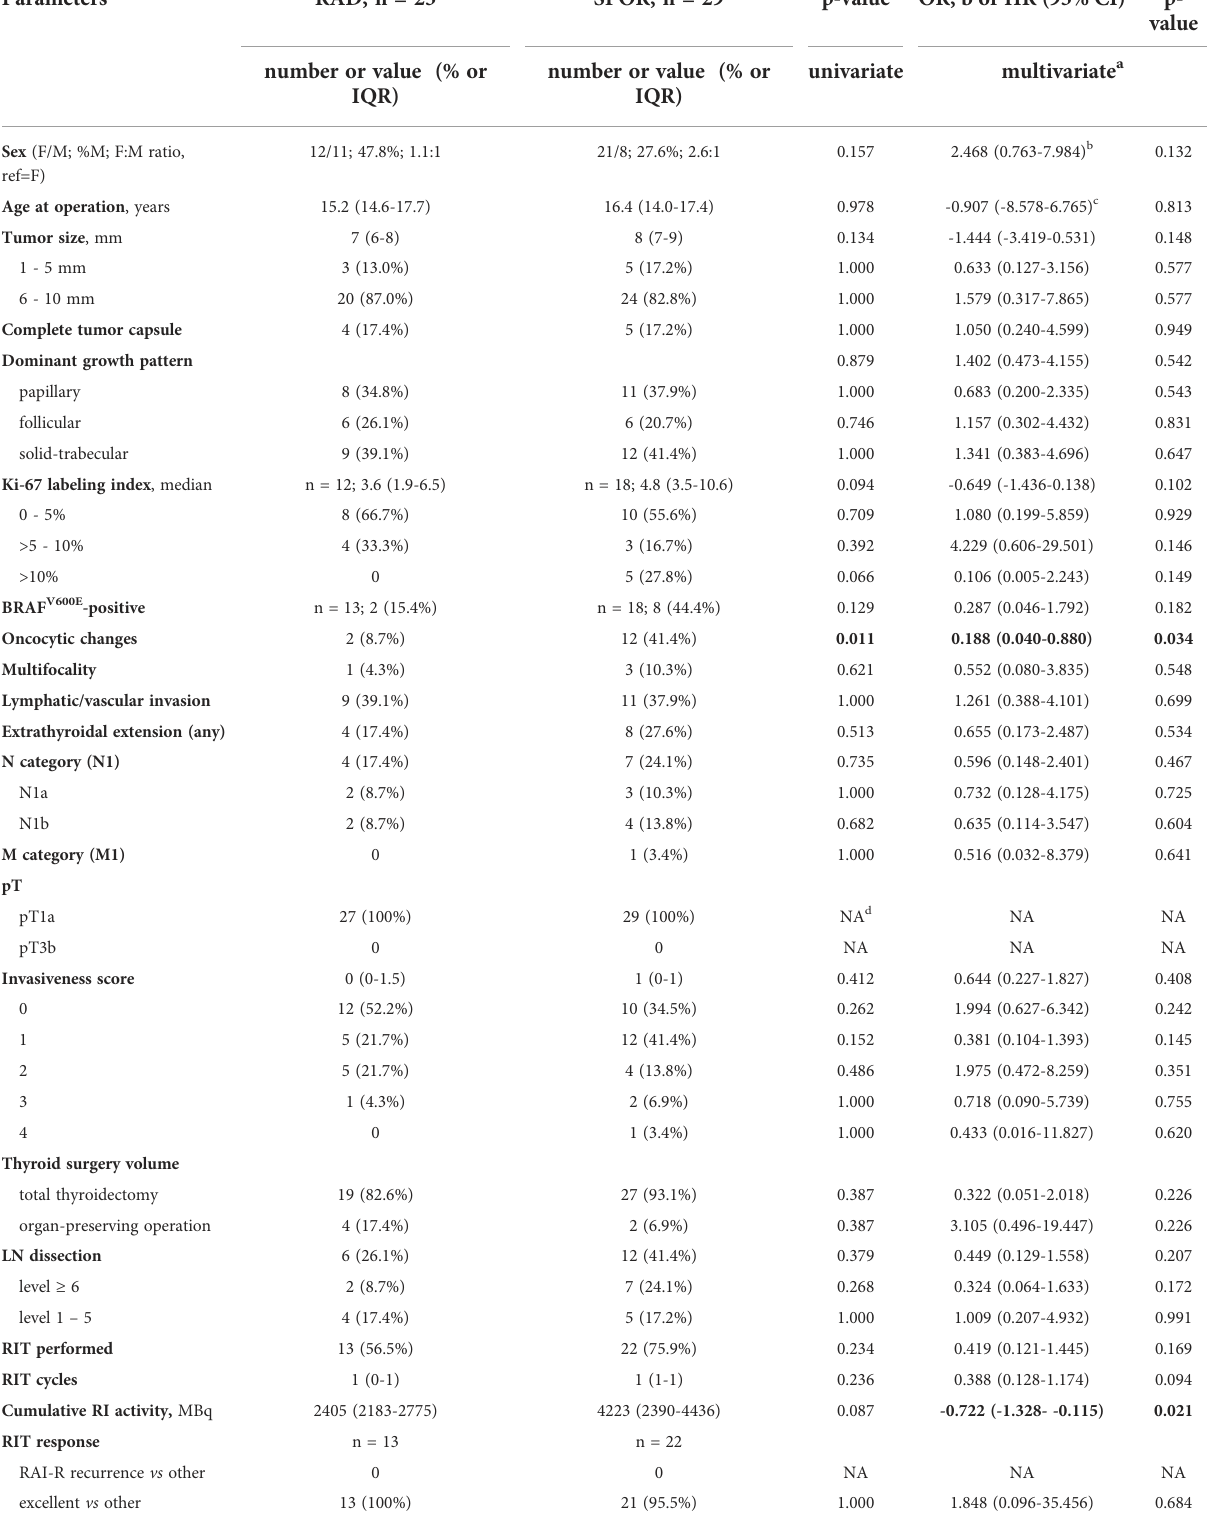
TABLE 2 Characteristics of the radiogenic and sporadic papillary thyroid microcarcinomas in pediatric patients aged ≤ 18